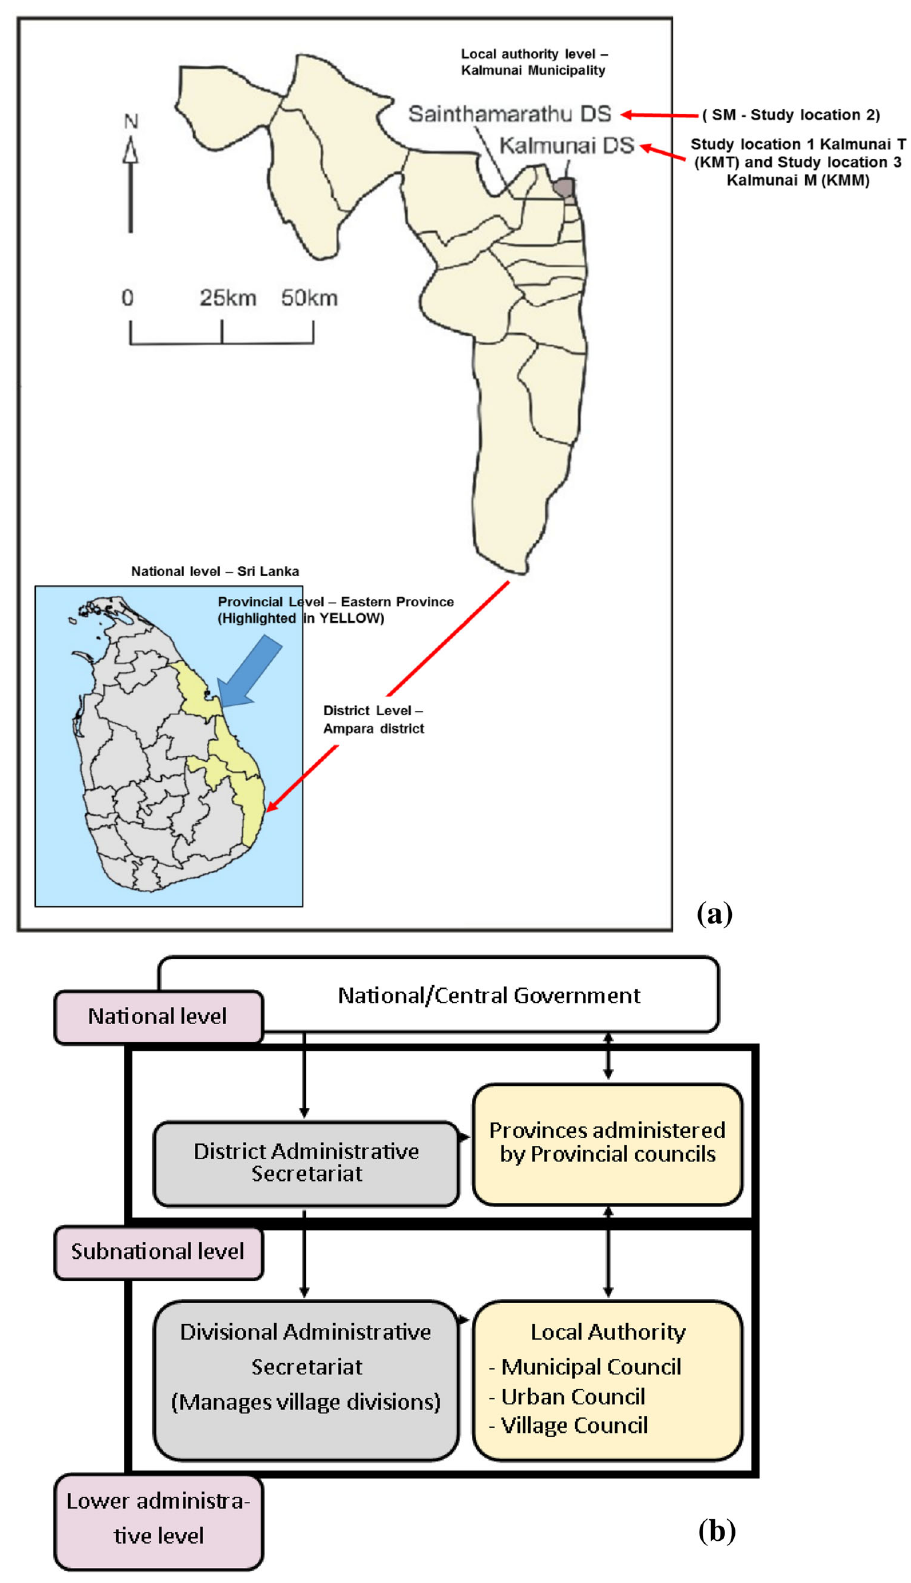
Fig. 2 a Case study area in Sri Lanka and the divisional case study locations. b Central/ devolved governance entities in Sri Lanka and their hierarchical